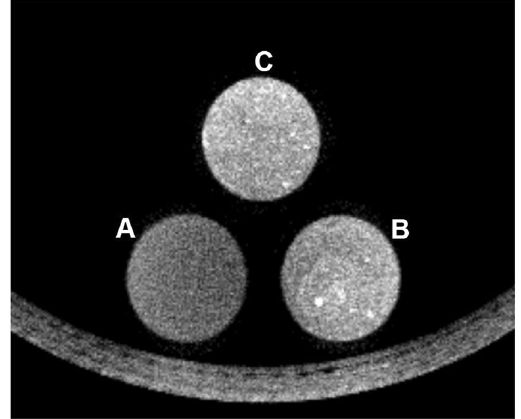
Figure 4. CT image of 2% agar phantom ( A , control), 2% agar mixed with SOF/TIBA/PLGA20 MSs by manual pipetting ( B ), and 2% agar mixed with SOF/TIBA/PLGA20 MSs by sonication ( C ).